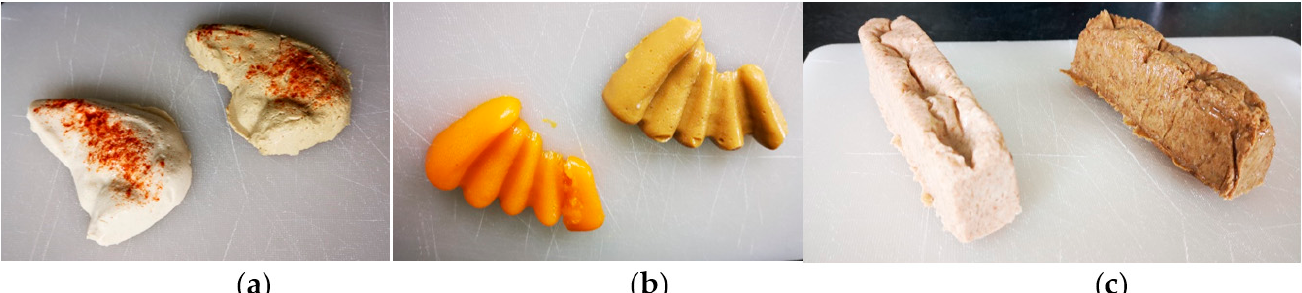
Figure 4. Texture-modified food products without ( left ) and with ( right ) the addition of RSM: ( a ) chicken breast; ( b ) carrots; ( c ) bread.